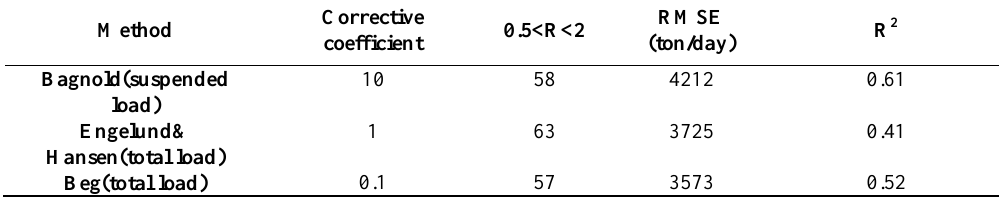
Fig.3. The proportion of computed and measured sediment load concentration for the Karun River with different equations Table4. Summary of applying corrective coefficient to produce better